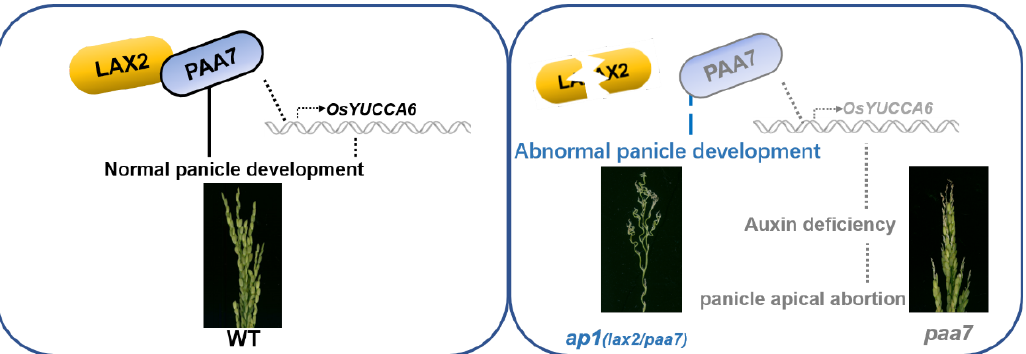
Figure 8. A working model for the FZP in the regulation of panicle development. In WT, PAA7/FZP could interact with LAX2 and activates OsYUCCA6 to control the development of rice panicle. In the paa7 mutant, lower expression led to downregulation of OsYUCCA6 and auxin deficiency in top spikelets of young panicle, finally resulting in panicle apical abortion; the loss of function of LAX2 aggravates the phenotype of paa7 mutant, which presented as ap1 (fizzy panicle).